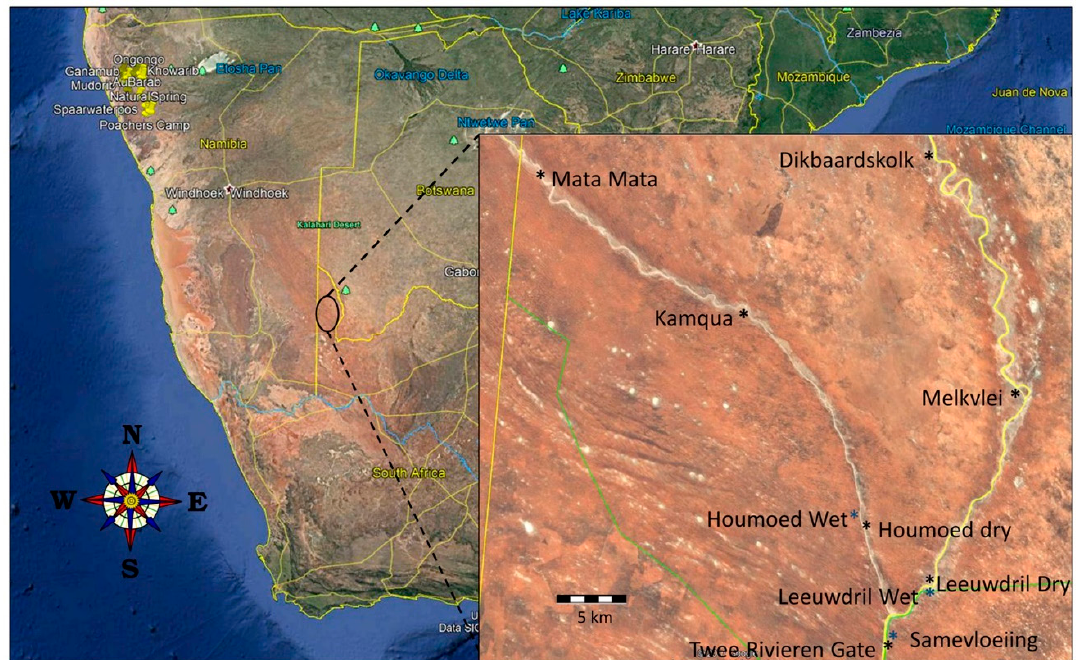
Figure 1. Map of southern Africa showing location of Kgalagadi Transfrontier Park, South Africa. Inset shows approximate sonar survey locations where SM2 + BAT sonar detectors were deployed along the Auob ( left ) and Nassob ( right ) river basins, as well as near the confluence of these two rivers (see Table 1 for GPS placement data). Blue and black asterisks indicate paired sites wherein one detector was positioned at a water source, and the other positioned about 1 km away at a dry site.